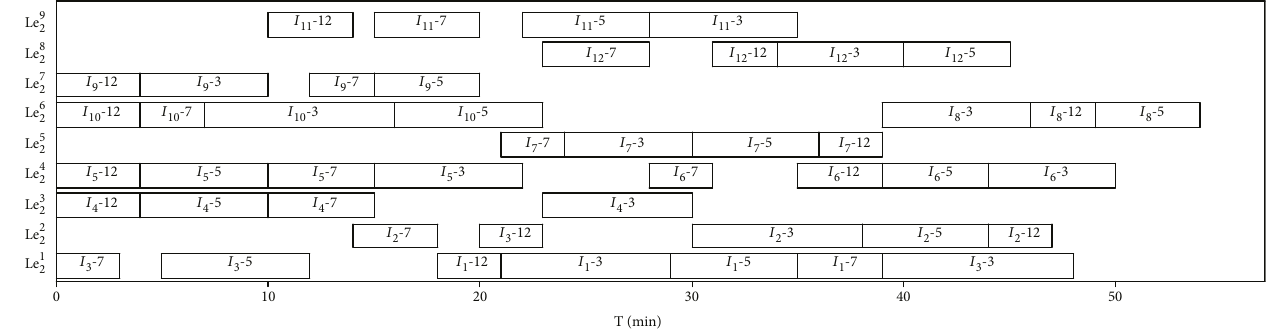
Figure 15: Gantt chart of robust support resource allocation of the second